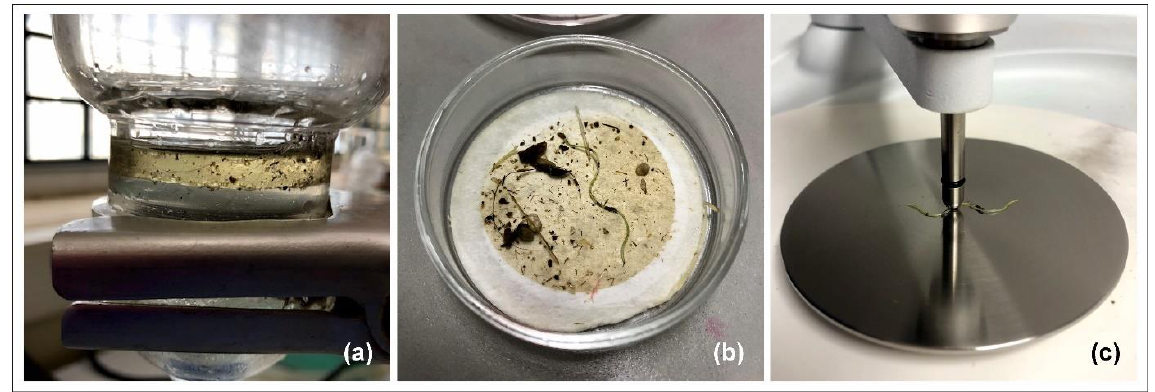
Figure 3. Images of the different separation and evaluations steps: ( a ) oil extraction, ( b ) microscopic analysis and ( c ) polymer identification.